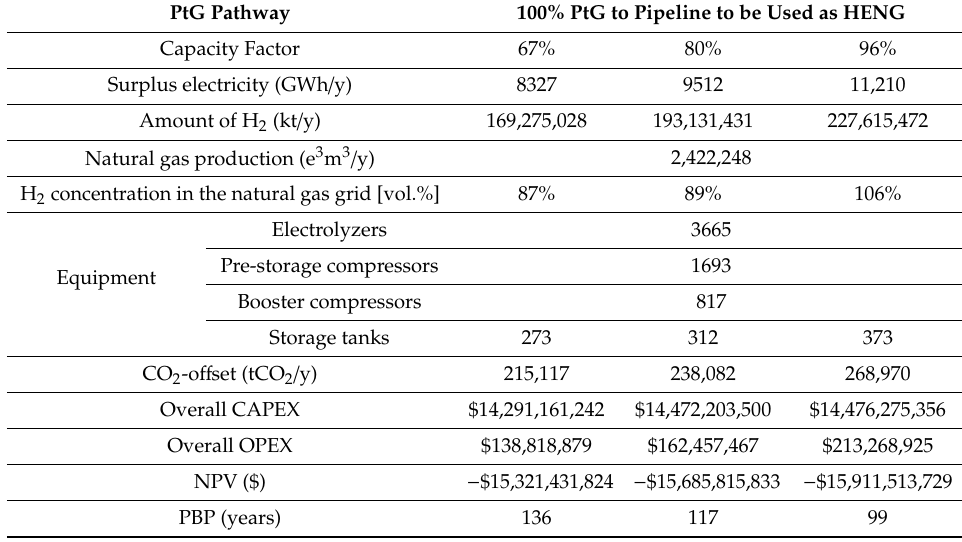
Table 10. Hydrogen allocation, Scenario